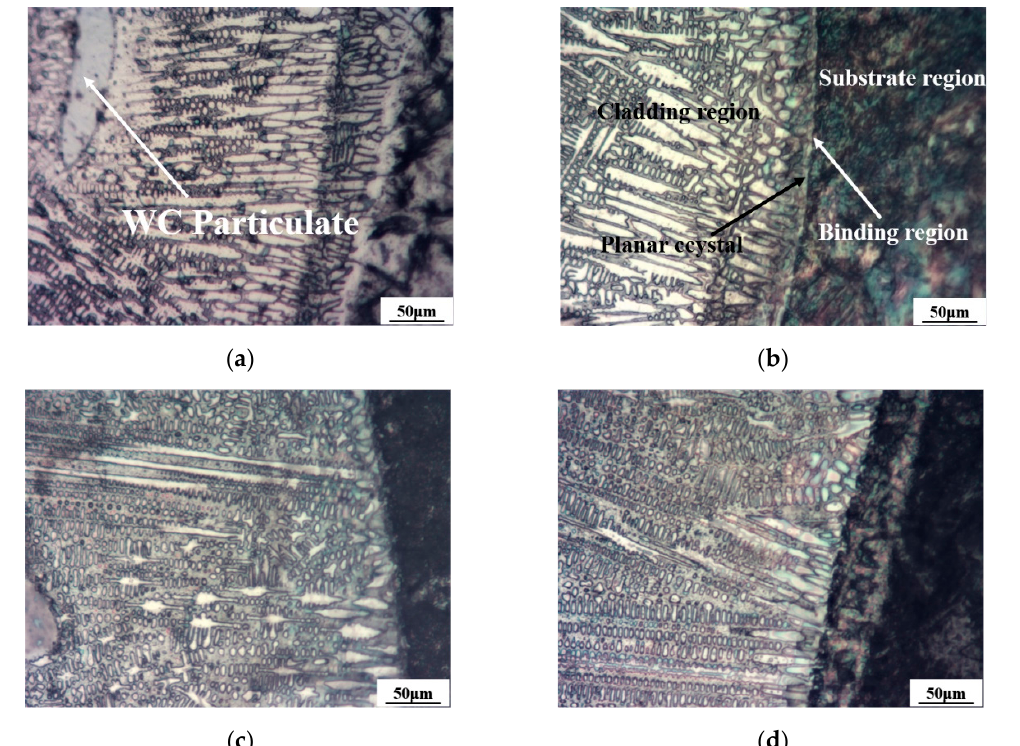
Figure 5. Metallographic structure of the cladding layer (65 Mn steel substrate): ( a ) microstructure of the 1200 W cladding layer and substrate; ( b ) microstructure of the 1400 W cladding layer and substrate; ( c ) microstructure of the 1600 W cladding layer and substrate; ( d ) microstructure of the 1800 W cladding layer and substrate.